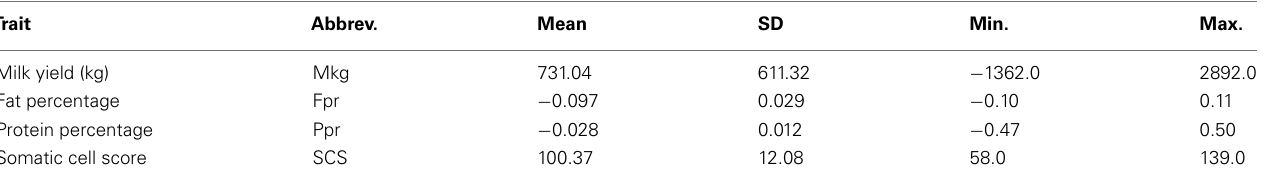
Table 2 | Descriptive statistics of EBVs for traits used in the analyses.